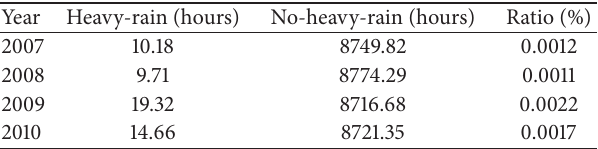
Table 3: Heavy rainfall rate.